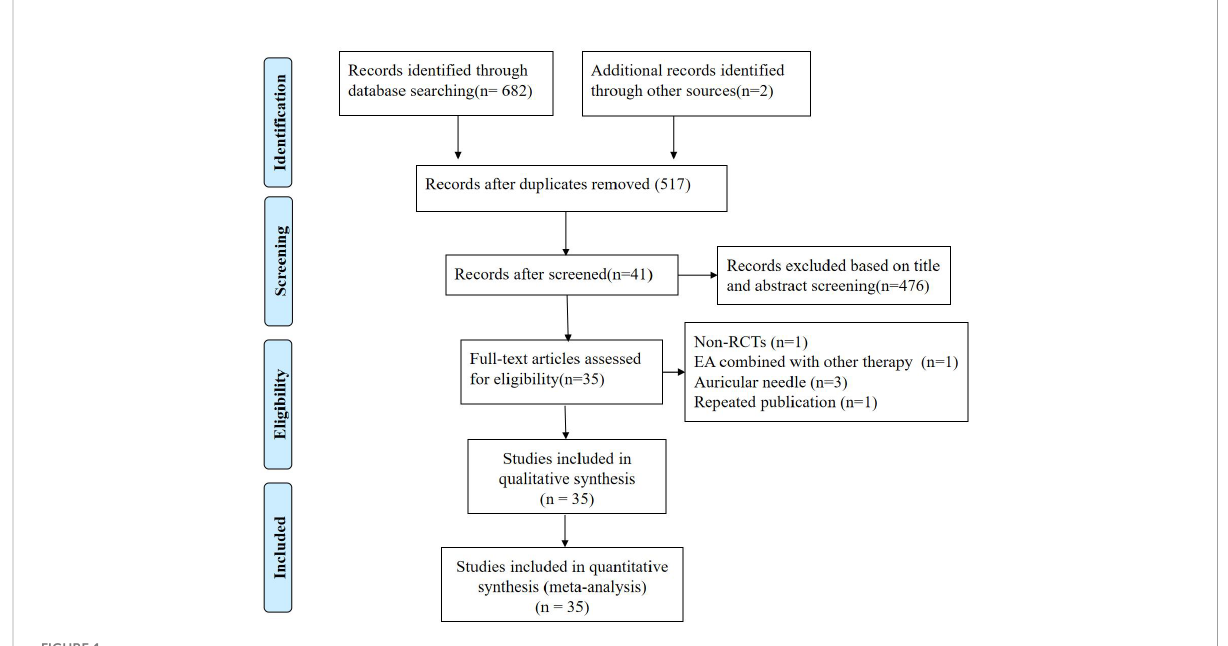
FIGURE 1 Flowchart of study